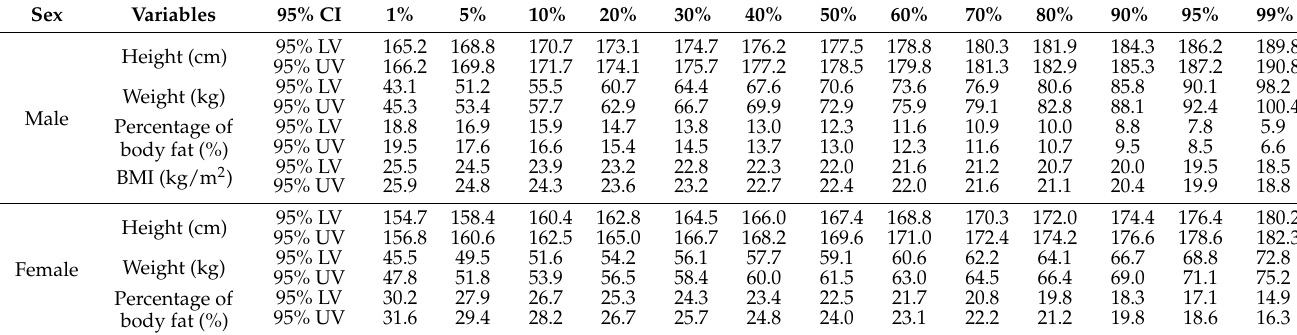
Table 6. Ninety-five percent confidence intervals for the Taekwondo athletes’ physical